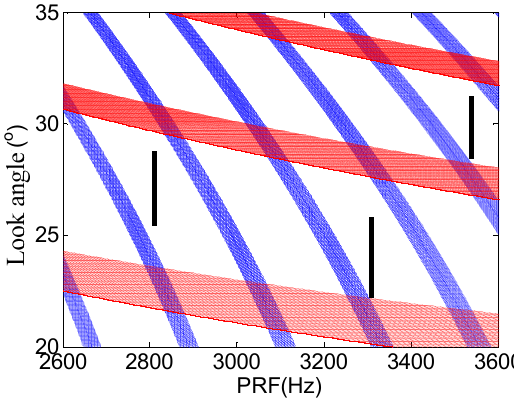
Figure 9. The timing diagram for wide-swath imaging with three-sub-swaths according to Table 1.